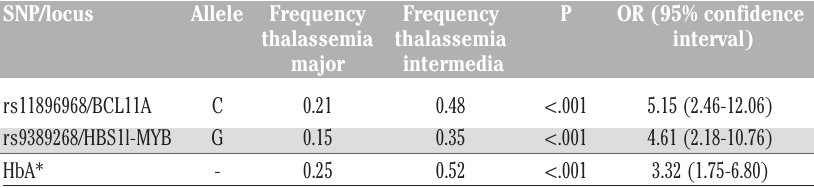
Table 3. Summary of the association with amelioration of β